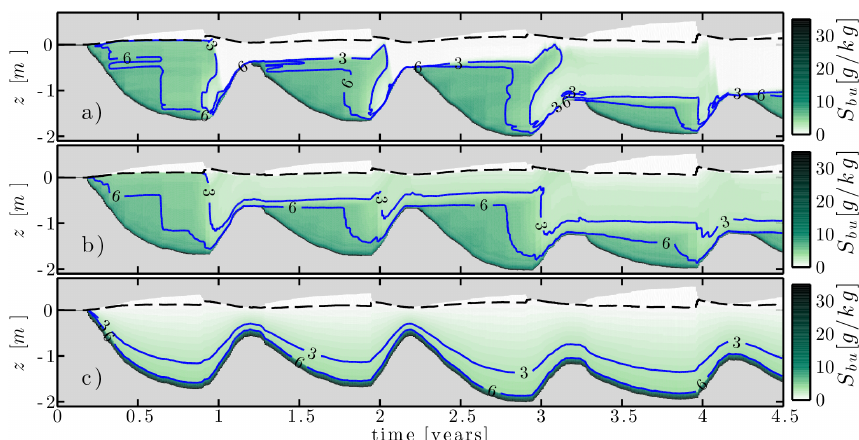
Figure 8. Salinity evolution of the (a) complex, (b) simple, and (c) prescribed salinity approach for one of the nine Arctic simulations forced with ERA-interim data from 75 ◦ N, 145 ◦ W. The salinity approaches are described in Sect. 2.5, and the model set-up is described in Sect. 4.1. The simulation time ( x axis) begins on 1 July 2005. The dashed line marks the snow–ice boundary. The water surface is at z = 0.